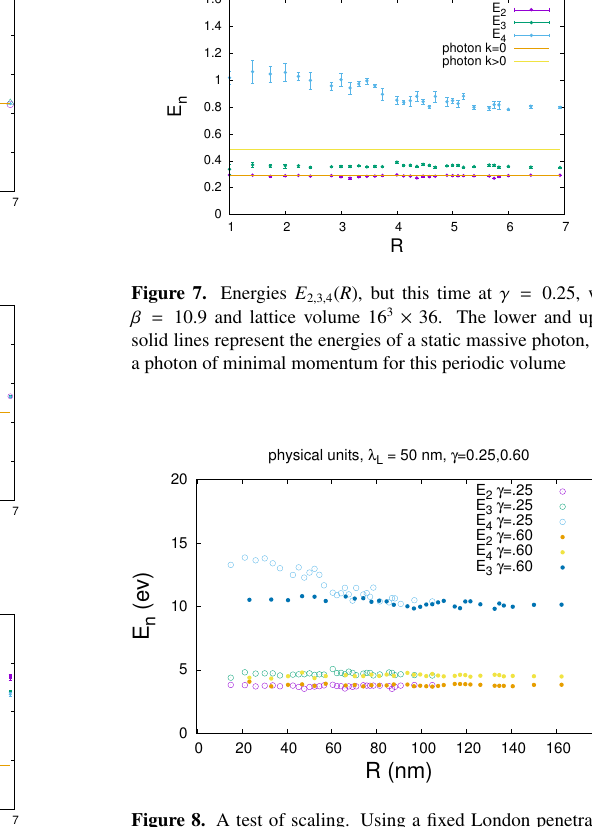
Figure 8. A test of scaling. Using a fixed London penetration depth of λ L = 50 nm to set the scale, we convert both R and E 2 , 3 , 4 ( R ) to physical units at both γ = 0 . 25 and γ = 0 . 60, with β = 10 . 9 fixed. sea is left in an excitation above the ground state, this re- duces the energy of the emitted electron, and this in turn a ff ects the line shape in the photoelectron spectrum. From this picture, Doniach and Sunjic [5] derived the observed asymmetric lineshape for peaks in the X-ray photoemis- sion spectrum. To quote from their article: “Thus the maximum photoelectron energy corresponds to the ground state of the hole + metal, while photoelectrons emitted be- low the maximum correspond to events in which the hole + Fermi sea is left in an excited state. Excited states with energies very close (a fraction of an electron-volt) to the ground state are those in which the Fermi sea is excited by the creation of low energy conduction electron-hole pairs (i.e. charge density fluctuations).” This is very similar to the process we are discussing in a superconductor. The di ff erence is that in the superconductor phase, with screen- ing from the Cooper pair condensate, a discrete spectrum of excitations of this condensate would lead to additional peaks in the spectrum, separated by a few ev from the main